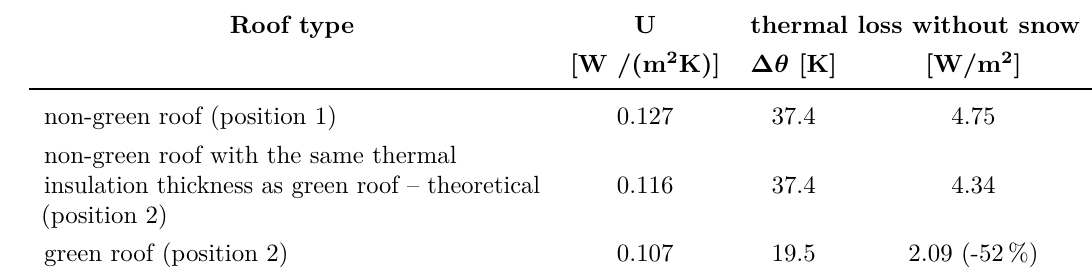
Table 3. Calculated thermal loss without snow based on the measured surface temperatures (Figure 8). vegetation during the same night -1.5 °C and for